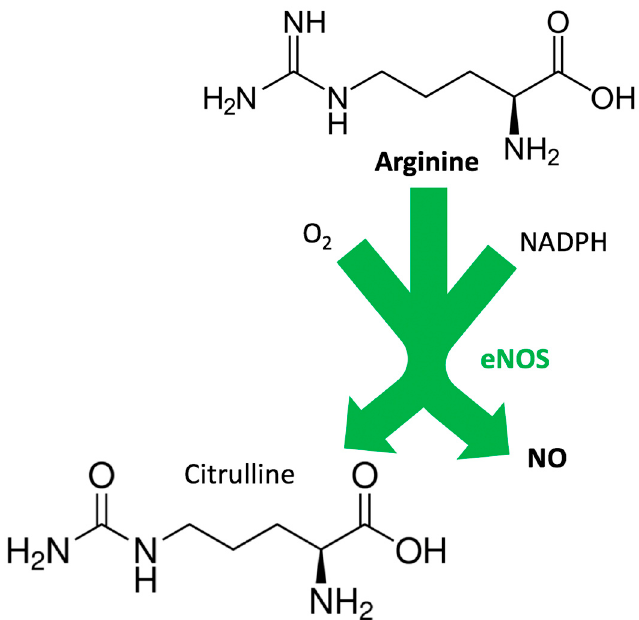
Figure 1. Functional role of arginine in the synthesis of nitric oxide (NO). NADPH: nicotinamide adenine dinucleotide phosphate; eNOS: endothelial NO synthase.